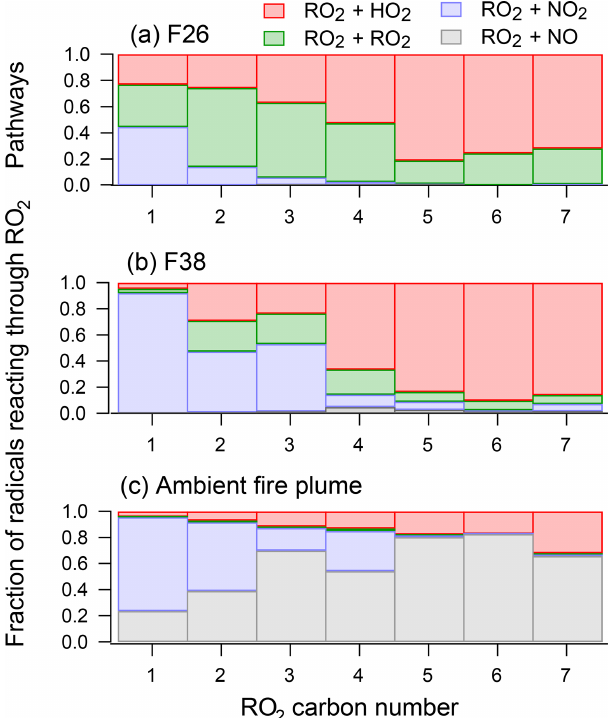
Figure 9. The fate of RO 2 species for (a) F26, (b) F38, and (c) the ambient biomass burning plume described by Müller et al. (2016). RO 2 species are grouped by carbon number, and the color of each bar shows the fraction of RO 2 species reacted by RO 2 + HO 2 , RO 2 + RO2, RO 2 + NO 2 , and RO 2 + NO